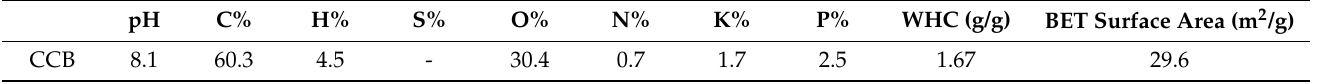
Table 2. Physical and chemical properties of CCB.